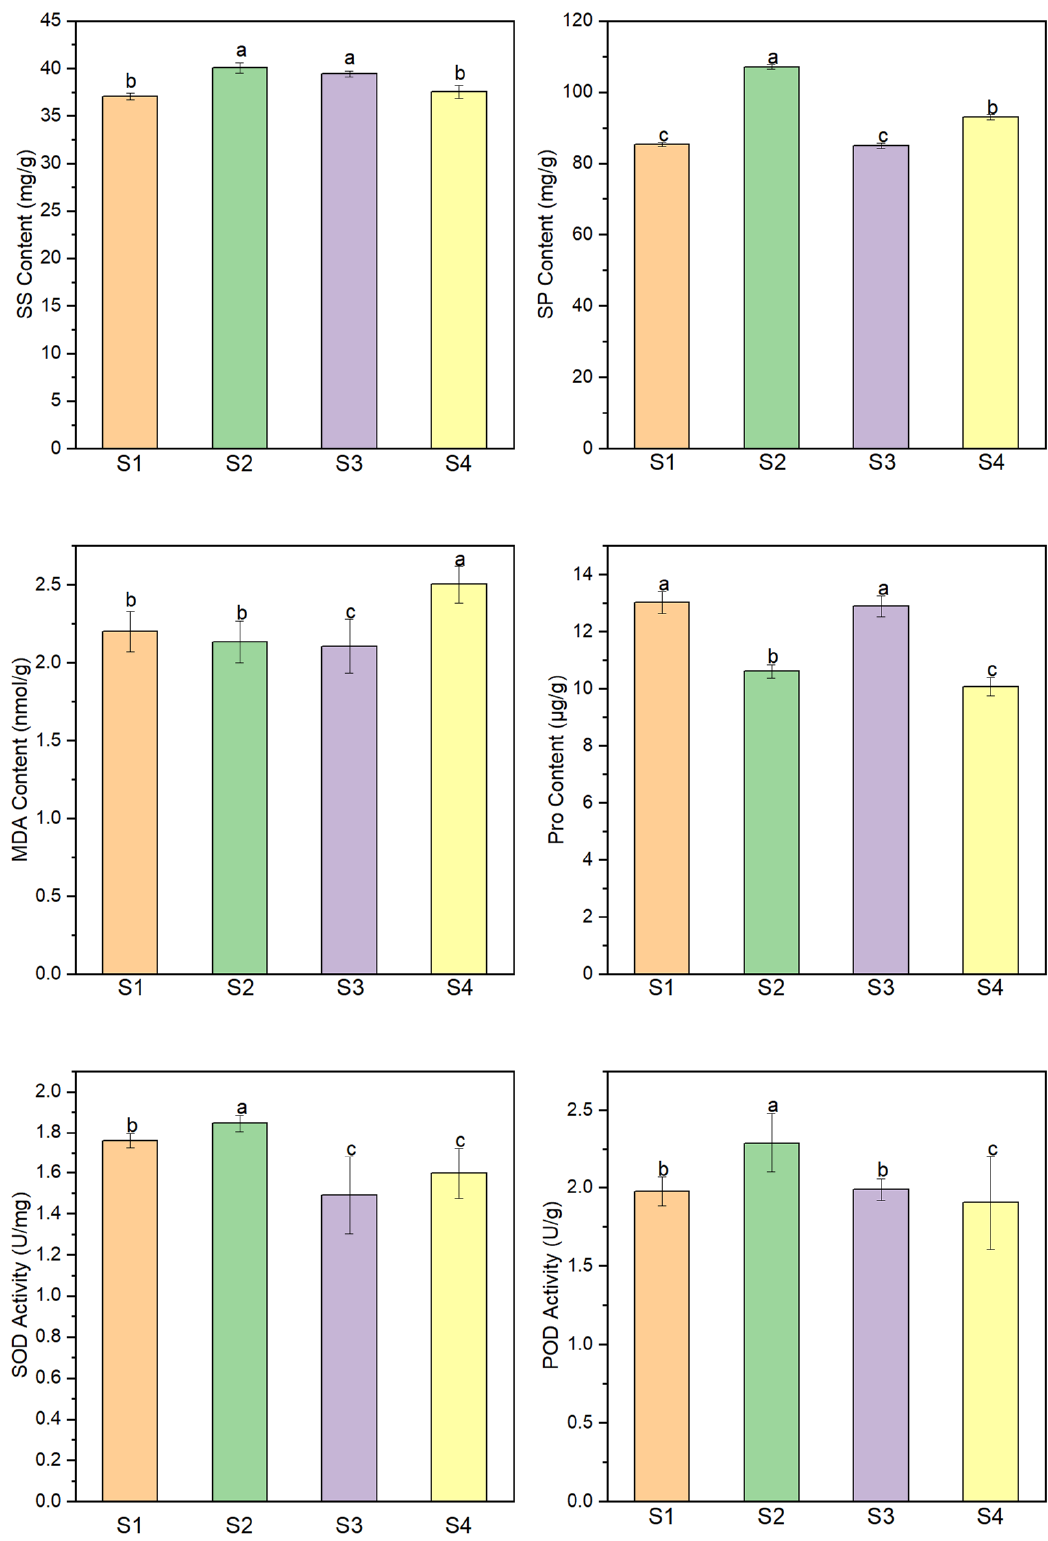
Figure 2. Physiological changes of Chinese fir seed germination, six indices (SS, SP, MDA, Pro, SOD, and POD). S1, S2, S3, and S4 represent the imbibition stage, the preliminary stage, the emergence stage, and the germination stage, respectively. Additionally, all the values are means ± standard errors, and di ff erent le tt ers above the bars indicate signi fi cant di ff erences.